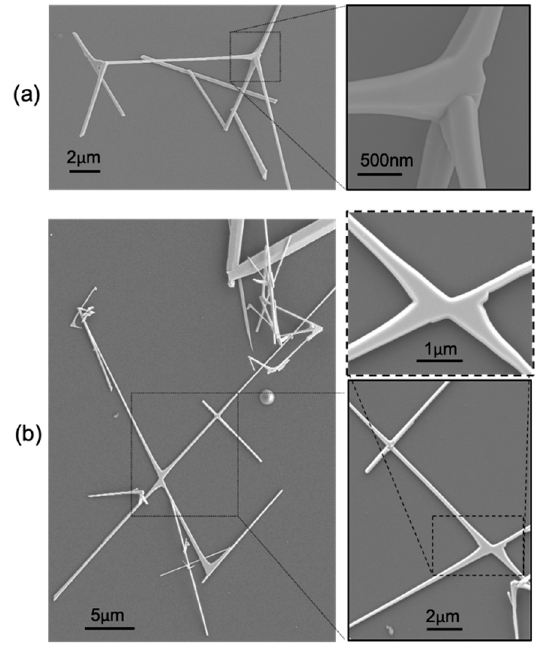
Figure 1. ( a , b ) Scanning electron microscopy (SEM) images of multi-branched SnO 2 NWs. Insets provide detailed view of the “node”, where the two or more branches originate.